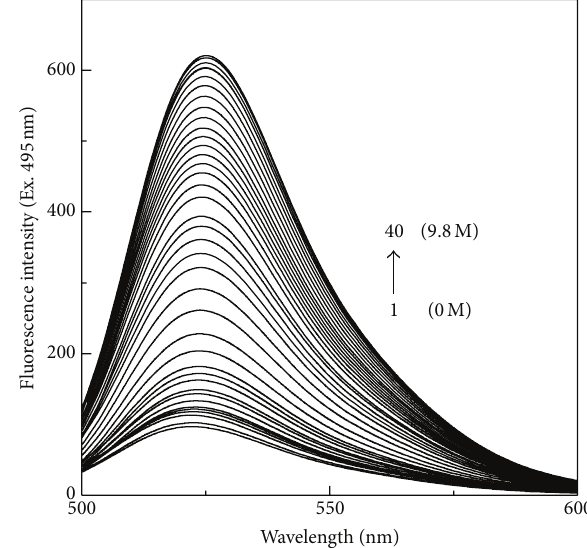
Figure 1: Fluorescence spectra of 0.50 𝜇 M FITC-BSA both in the absence (—) and presence of 10% (– ⋅ ⋅ –) and 20% ( ⋅ ⋅ ⋅⋅ ) (w/v) honey upon excitation at 495 nm. Fluorescence spectrum of 0.5 𝜇 M BSA (---) is also shown.